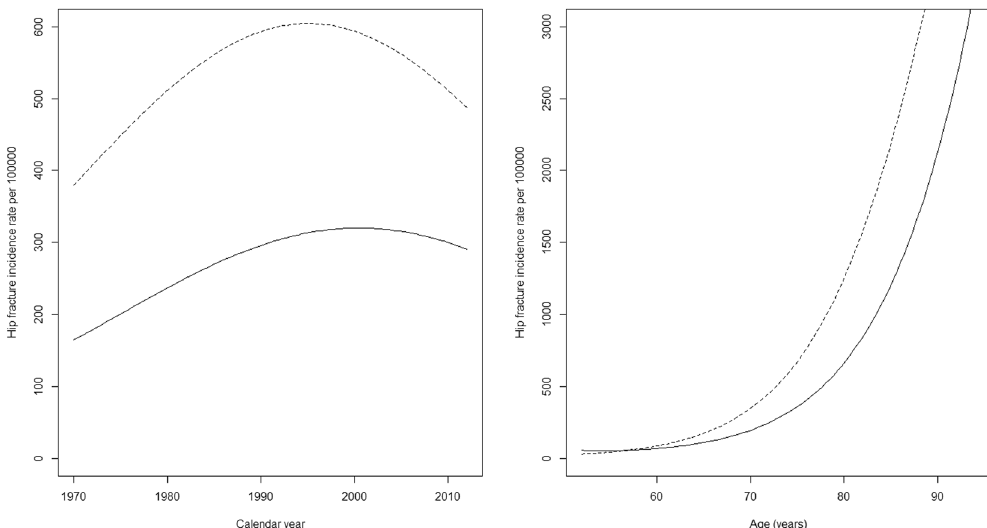
Figure 2. Predicted fixed effects of calendar year and age on hip fracture incidence in women (dashed line) and men (solid line). To plot predicted values, the effect of calendar year was modelled for the average age in the sample (74 years) and the effect of age modelled for the average calendar year (2000).